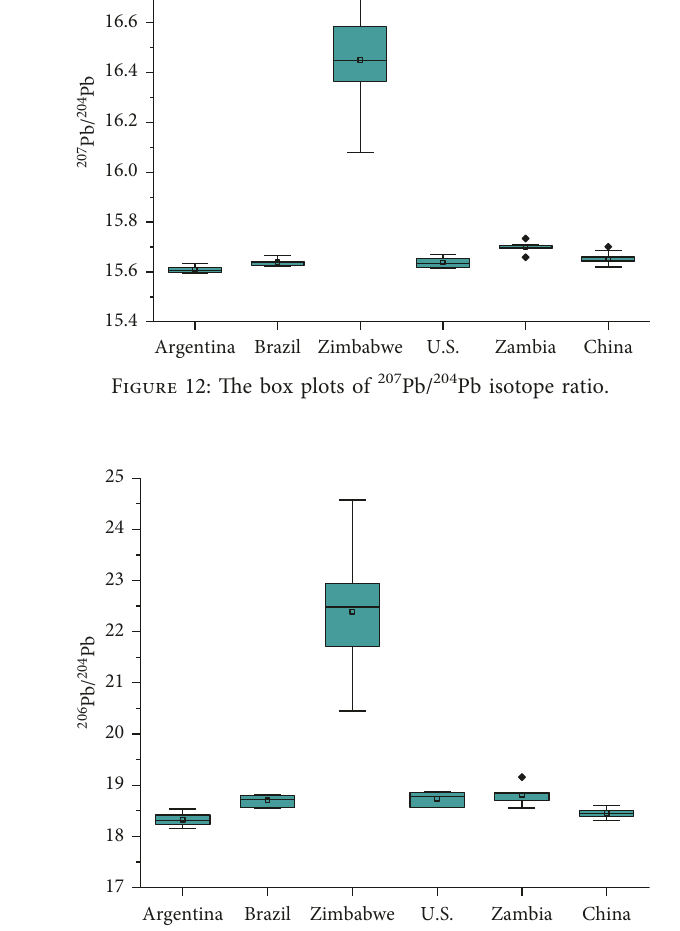
Figure 13: The box plots of 206 Pb/ 204 Pb isotope ratio in tobacco leaf from different countries in tobacco leaf from different countries. Table 3: Fisher’s linear discriminant classification function